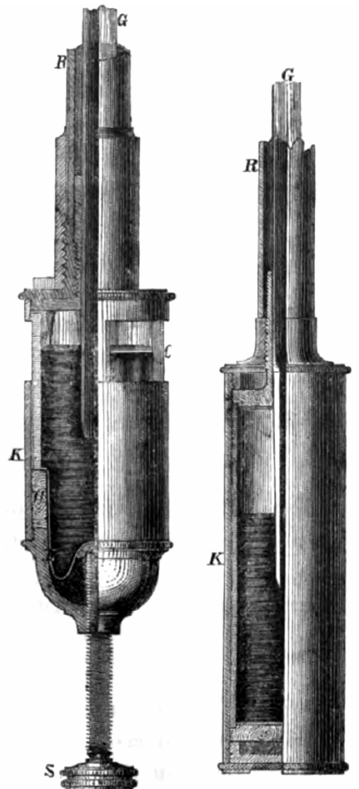
Figure 2. Drawing of the cisterns of a Fortin barometer (left) and of a fixed-cistern barometer (right). In the Fortin barometer a screw (indicated by the letter “S”) allows the adjustment of the level of the mercury in the cistern. From Jelinek